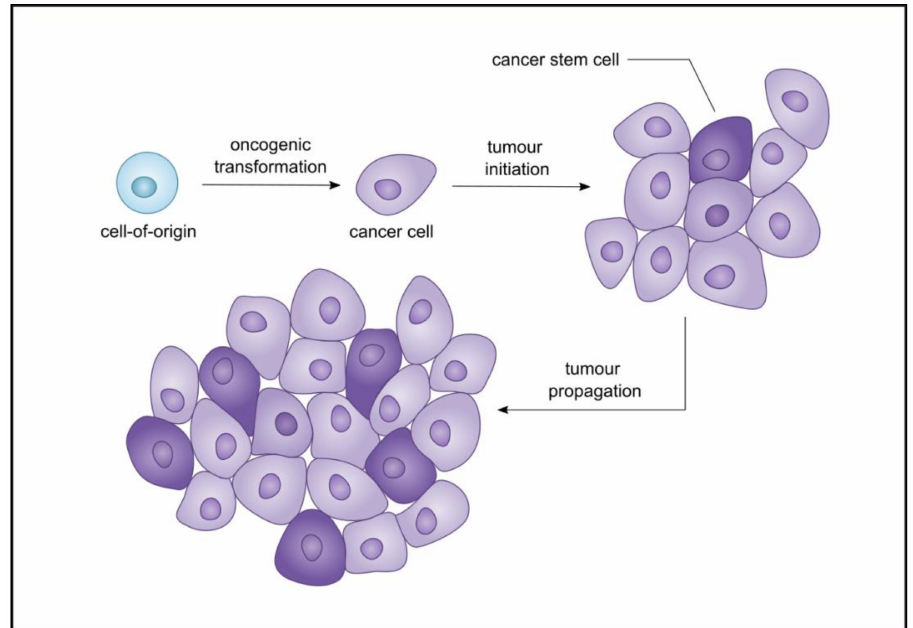
Figure 1. The distinction between cancer stem cells (CSCs) and cancer-initiating cells. A cancer-initiating cell (in blue) undergoes oncogenic transformation in order to develop a tumour, while a cancer stem cell (CSC, in dark purple) is not necessarily the transformed tissue-specific stem cell, but rather gives rise to the bulk of the